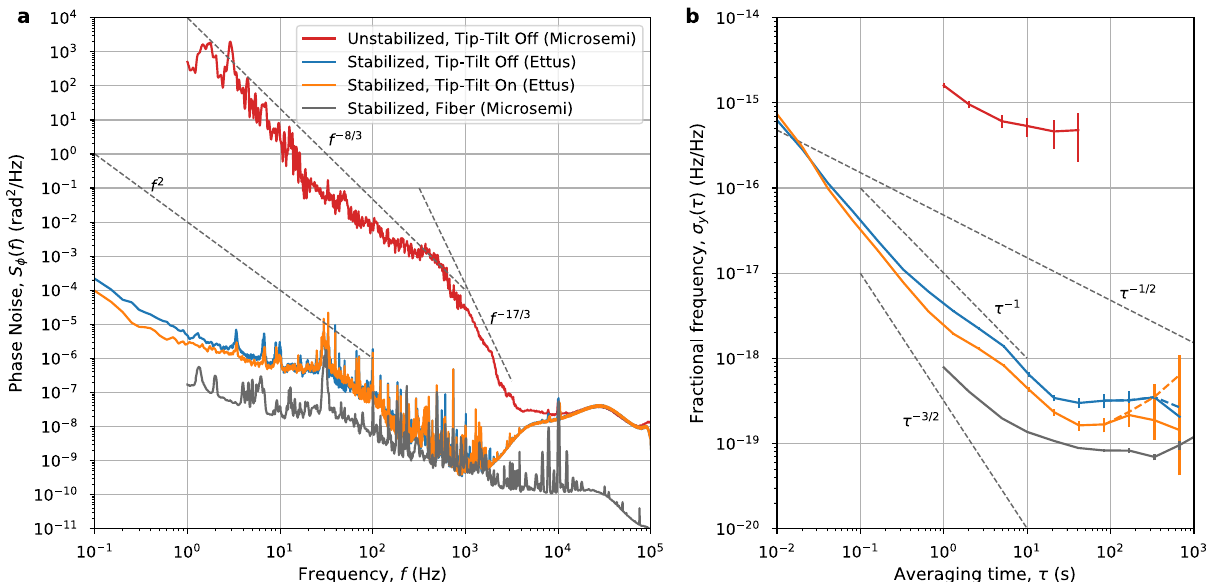
Fig. 2 Phase and frequency stability of the optical transmission measured at the remote site. Red trace, free-space link phase stabilization off, tip-tilt active optics off (data from Microsemi); blue trace, free-space link phase stabilization on, tip-tilt active optics off (data from Ettus); orange trace, free-space link phase stabilization on, tip-tilt active optics on (data from Ettus); and gray trace, system noise fl oor with both phase stabilization systems transmitting over parallel optical fi ber (data from Microsemi). a Power spectral density of the phase noise ( S ϕ ( f )) after transmission. b Fractional frequency stability presented as modi fi ed Allan deviation ( σ y ( τ )). The dashed traces are calculated from raw data; the solid traces are calculated from data with quadratic drift removed; and the error bars represent a standard fractional frequency measurement con fi dence interval set at ± σ y ð τ Þ = phase measurements. On both plots, the black dashed lines show key gradients of